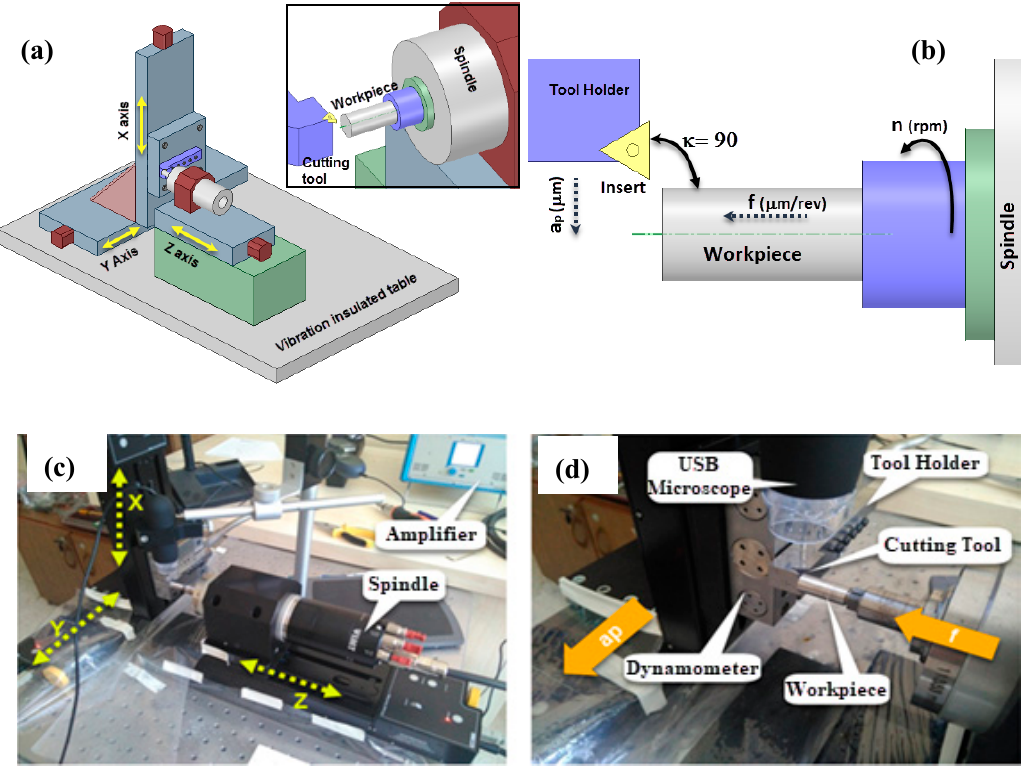
Figure 3. ( a ) Schematic representation of micro-turning setup; ( b ) position of cutting tool and workpiece relative to each other; ( c ) axis definitions of experimental setup; ( d ) close view of cutting setup.